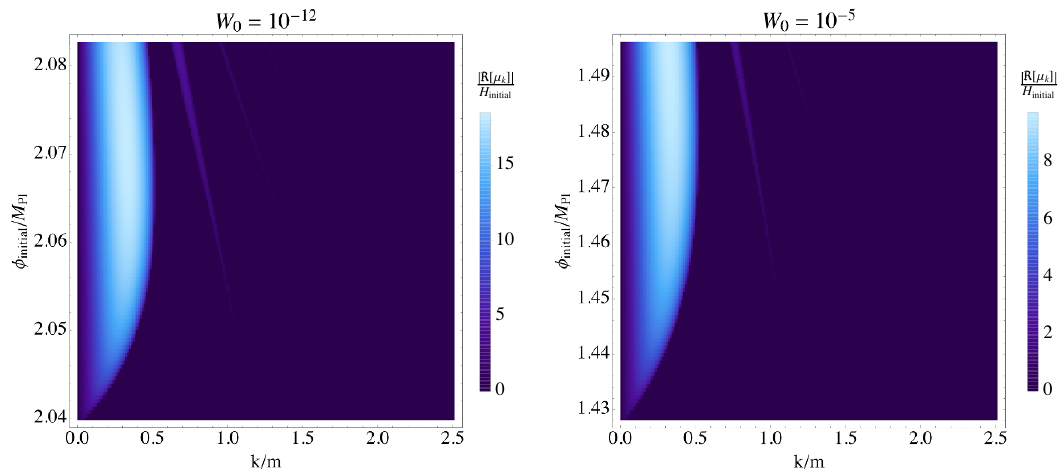
(cid:0) 12 (left) and 0 = 10